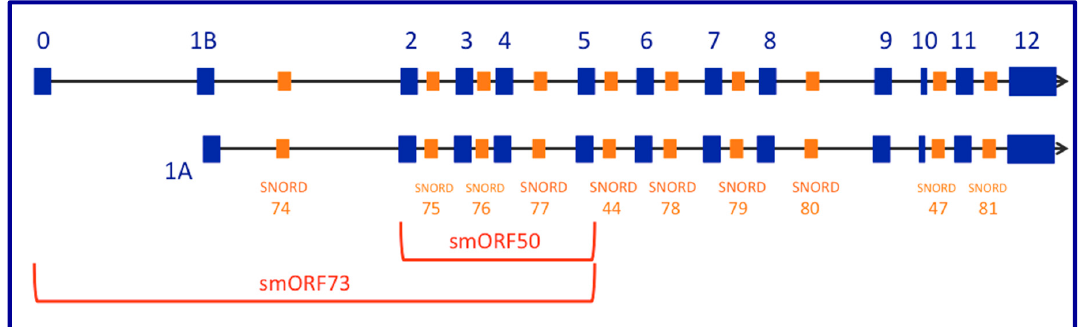
Figure 1. Simplified schematic of the human GAS5 transcription unit. Shown in royal blue at the top are the 13 exons that comprise Ensemble transcript ENST00000430245.1 (or GenBank Accession NR_152521; 725 nt). The second line is the schematic of the 12 exons that comprise Ensemble transcript isoform (GenBank NR_152531; 684 nt). Orange boxes represent the location of the ten snoRNA elements encoded within introns. At the bottom are red brackets covering the four exons encoding smORF50 or the six exons encoding smORF73. Notice that exon 1B (top line; 29 nt) is not the same as exon 1A (bottom line; 32 nt). Only two of the more than two dozen human GAS5 transcript isoforms are shown in this simplified schematic.